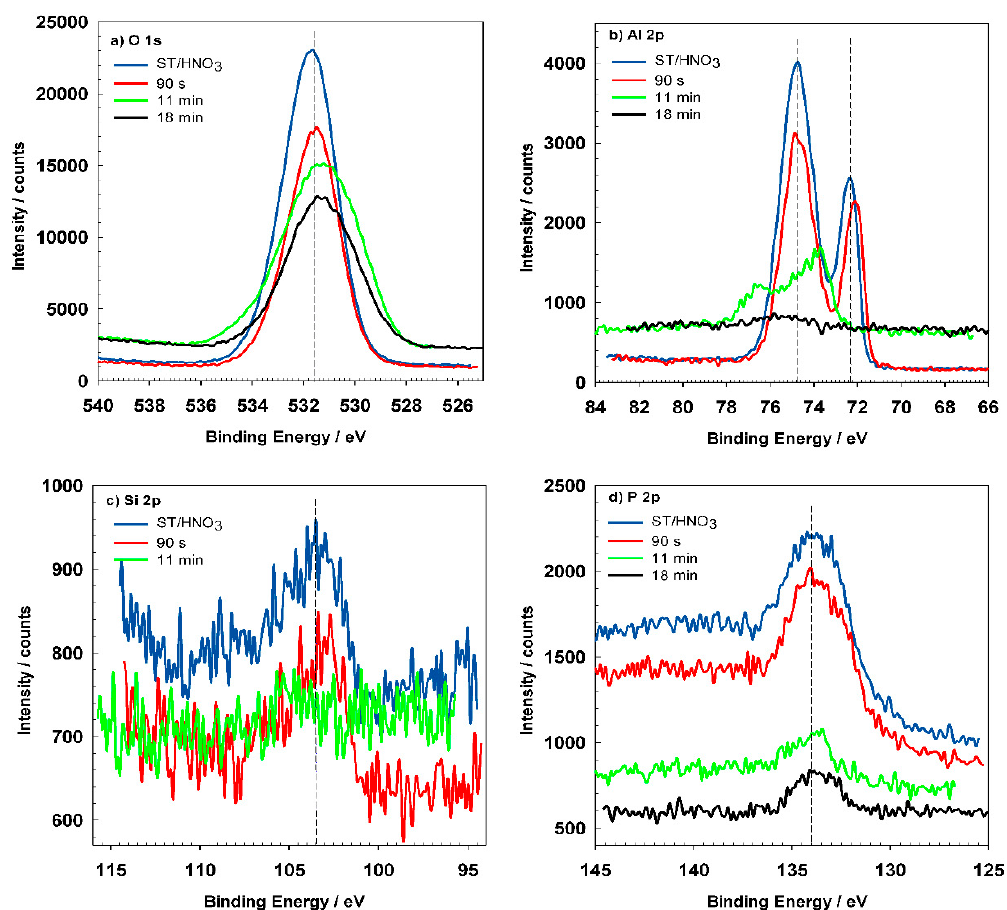
Figure 15. High-resolution XPS spectra of ( a ) O 1s, ( b ) Al 2p, ( c ) Si 2p and ( d ) P 2p recorded for AA3003 samples after chemical cleaning using ST/HNO 3 and then coated using 10% ST650 conversion coatings prepared at different conversion times: 90 s, 11 min and 18 min at room temperature. Spectra were not normalized on the intensity scale.